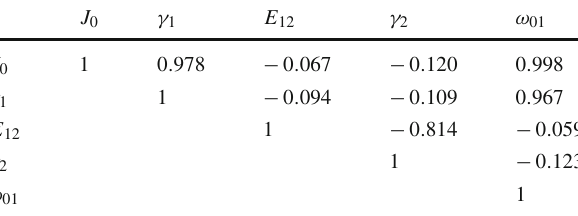
Table 9 Elements of the correlation matrix (statistical uncertainties) of the spectral parameters describing the SD-750 energy spectrum at the nominal energy scale